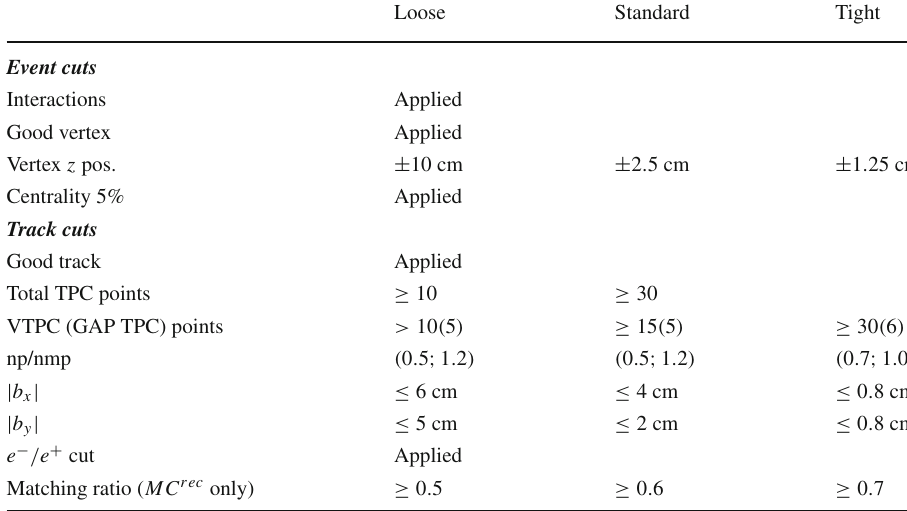
Loose Standard Tight